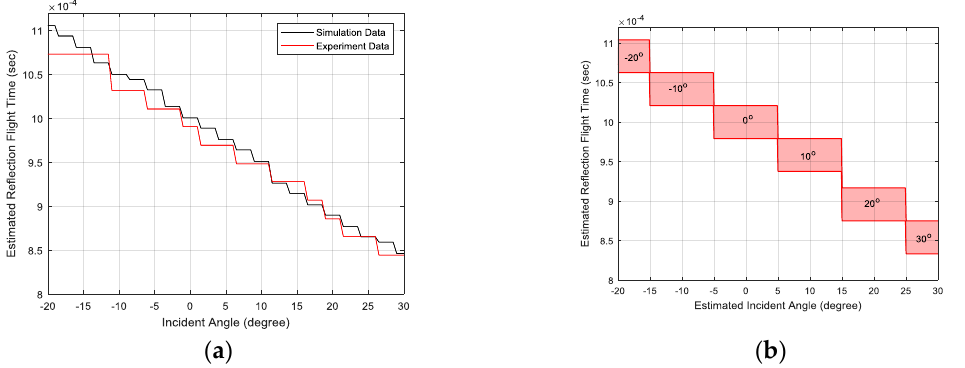
Figure 14. ( a ) The simulation and experimentation results for RFT from SRIR within the study range and ( b ) the discrete linear model for estimating AoA from RFT. Each red box represents the single 10-degree angle, such as −20° and −10°.